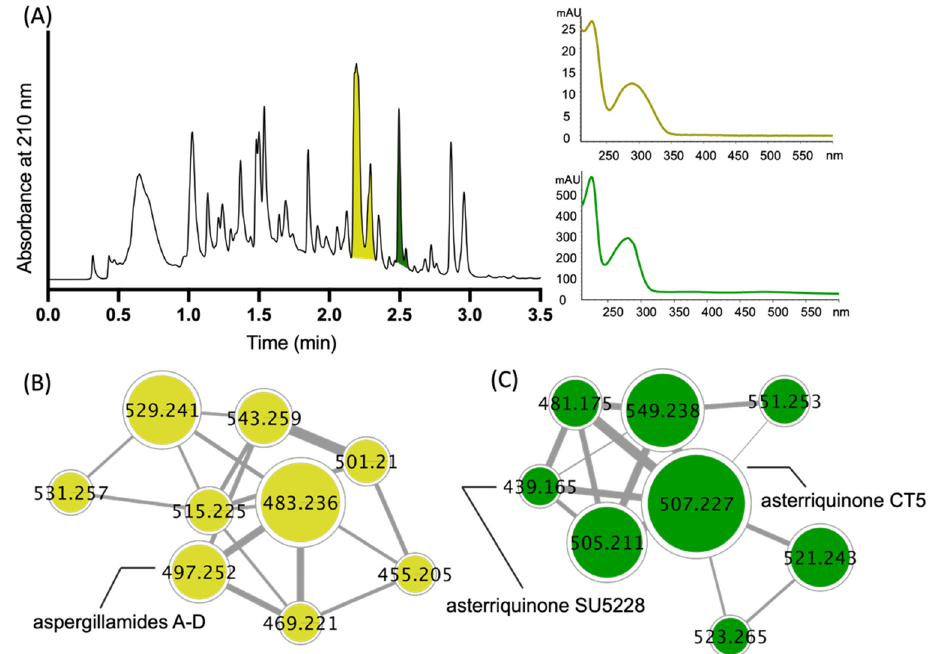
Figure 2. ( A ) UPLC-DAD (210 nm) chromatogram of the CMB-MRF324 SDA extract with UV-vis profiles for two key structure classes, and GNPS molecular families (clusters) for ( B ) aspergillamides and ( C ) asterriquinones. Highlights; aspergillamides (yellow); asterriquinones (green).